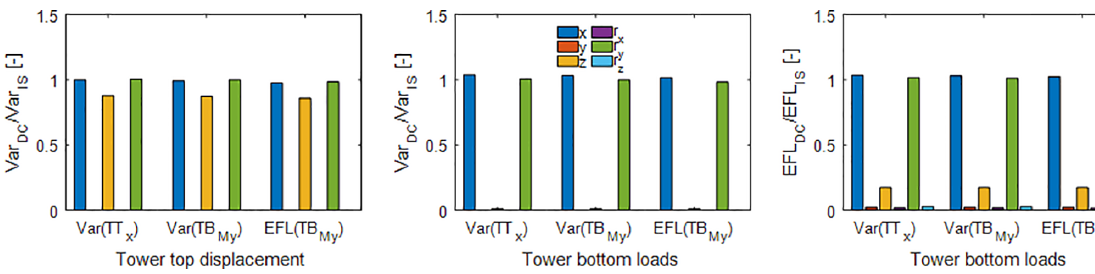
Figure 7. Response for tower top displacements and tower bottom loads for wind speed of 20ms − 1 and DC